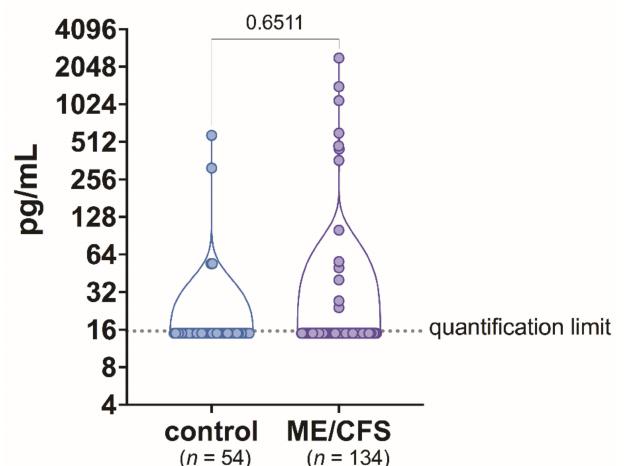
Figure 1. Activin B level in blood plasma samples of patients with ME/CFS and control group